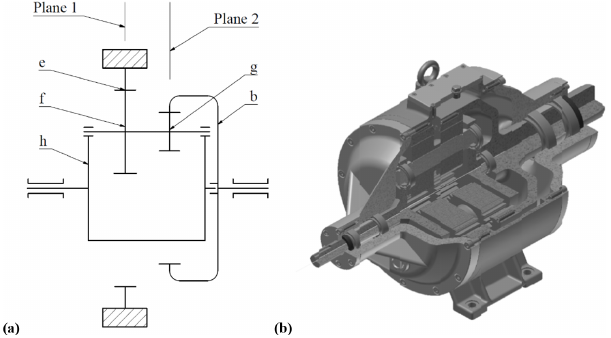
Figure 1. Planetary reducer with double planet gears; (a) kinematic scheme (h – planet gear carrier; e – stationary ring gear; f, g – planet gears; b – movable ring gear); (b) 3D model.